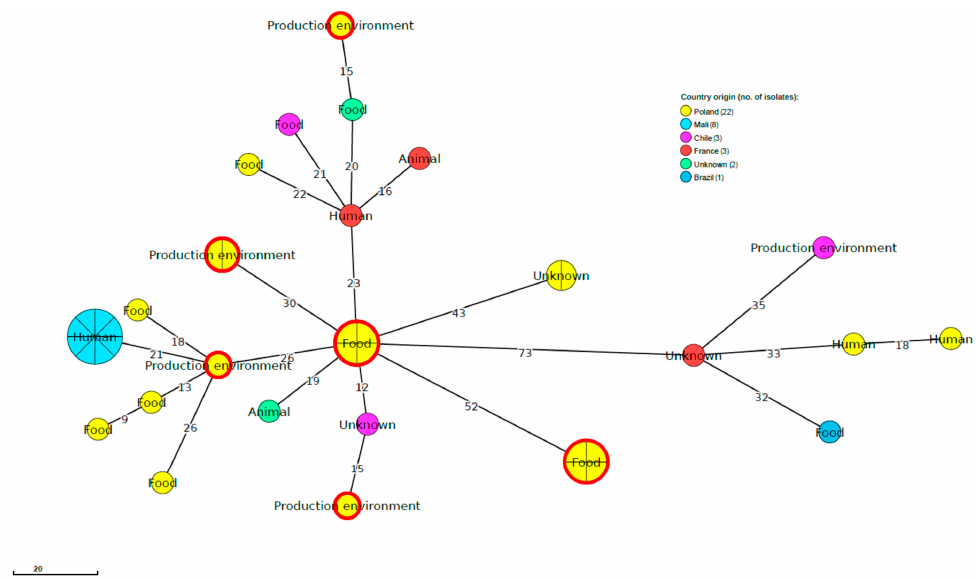
Figure 2. MST based on the cgMLST profiles of 13 L. monocytogenes strains studied belonging to SL121 together with 26 SL121 strain profiles publicly available at BIGSdb-Lm (listed in Table S2). cgMLST are represented by colored circles where size is proportional to the number of isolates. Numbers on the branches show alleles differences between neighboring nodes. Circles with red rim represent L. monocytogenes strains from the present study.